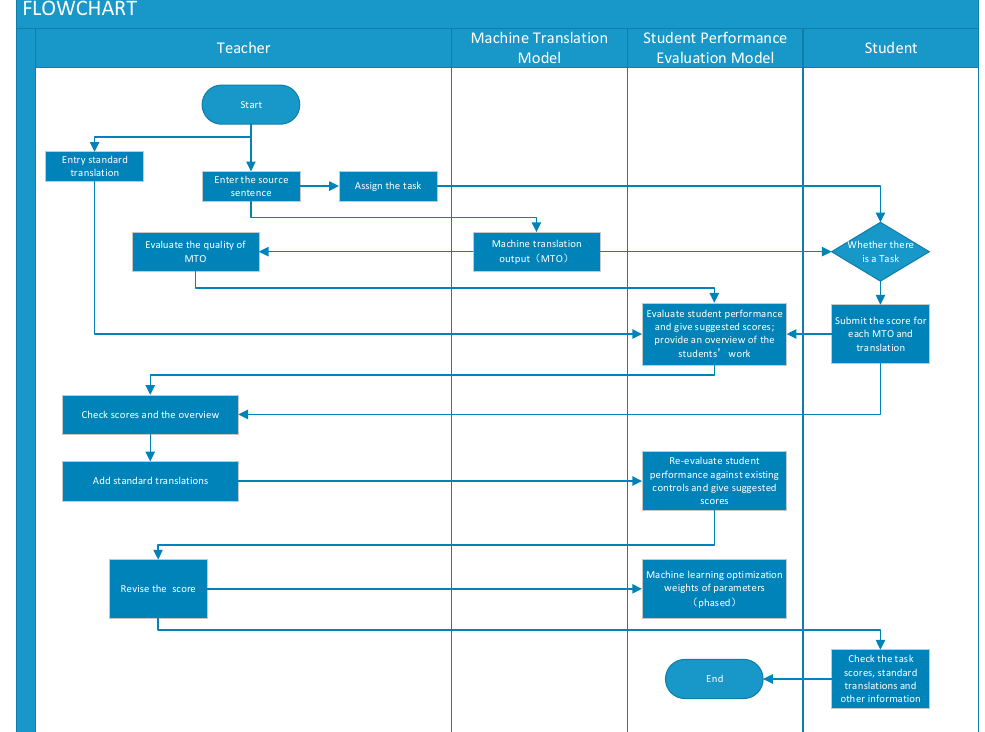
Figure 1. The Architecture of TFCAS.